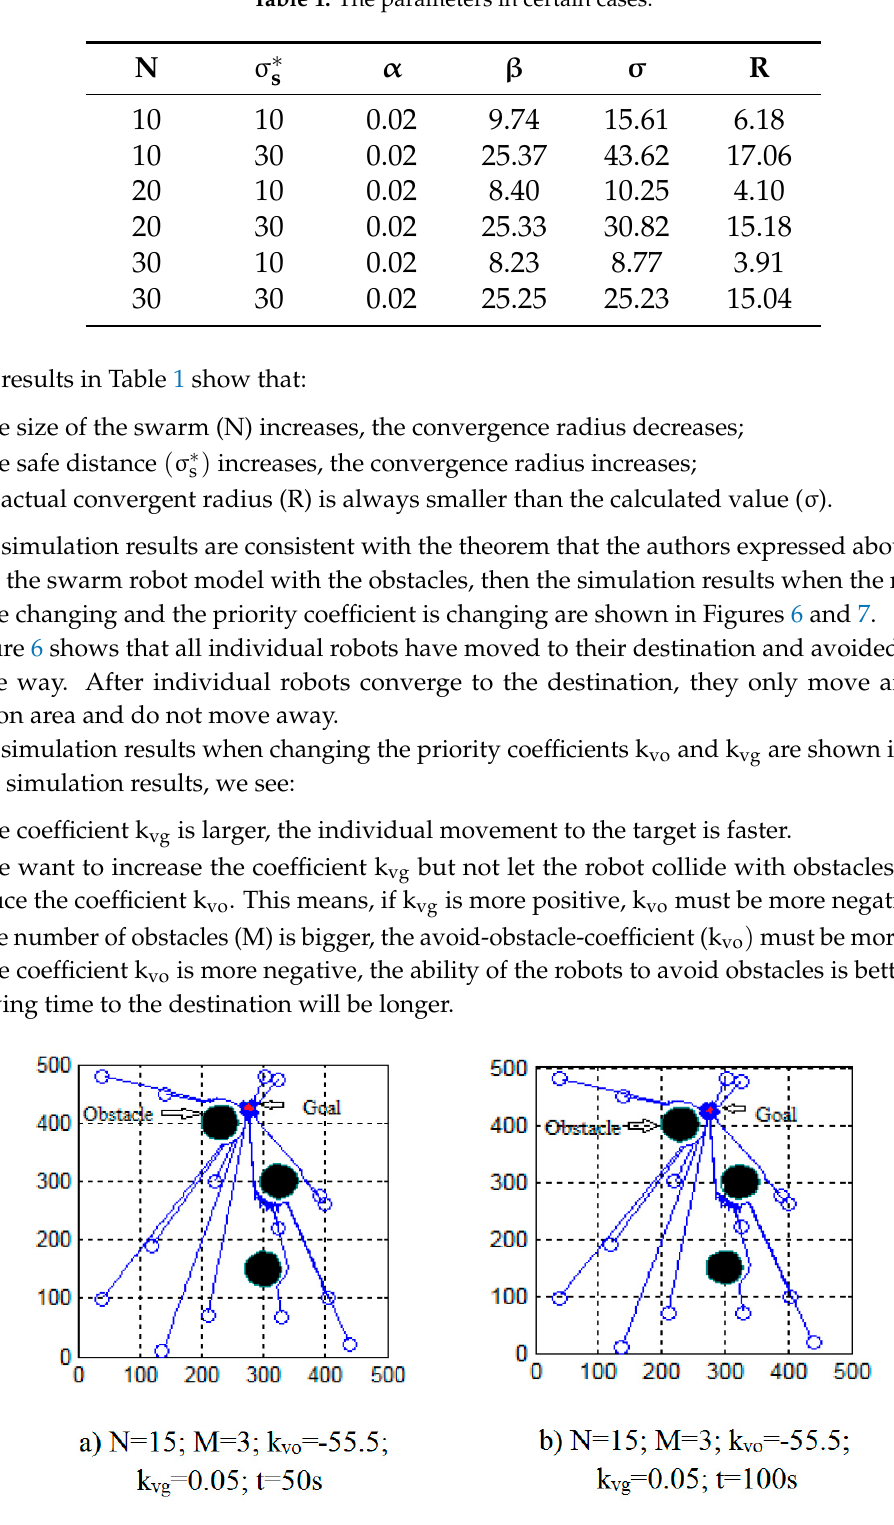
Figure 6. The simulation results of the multi task process after a period.